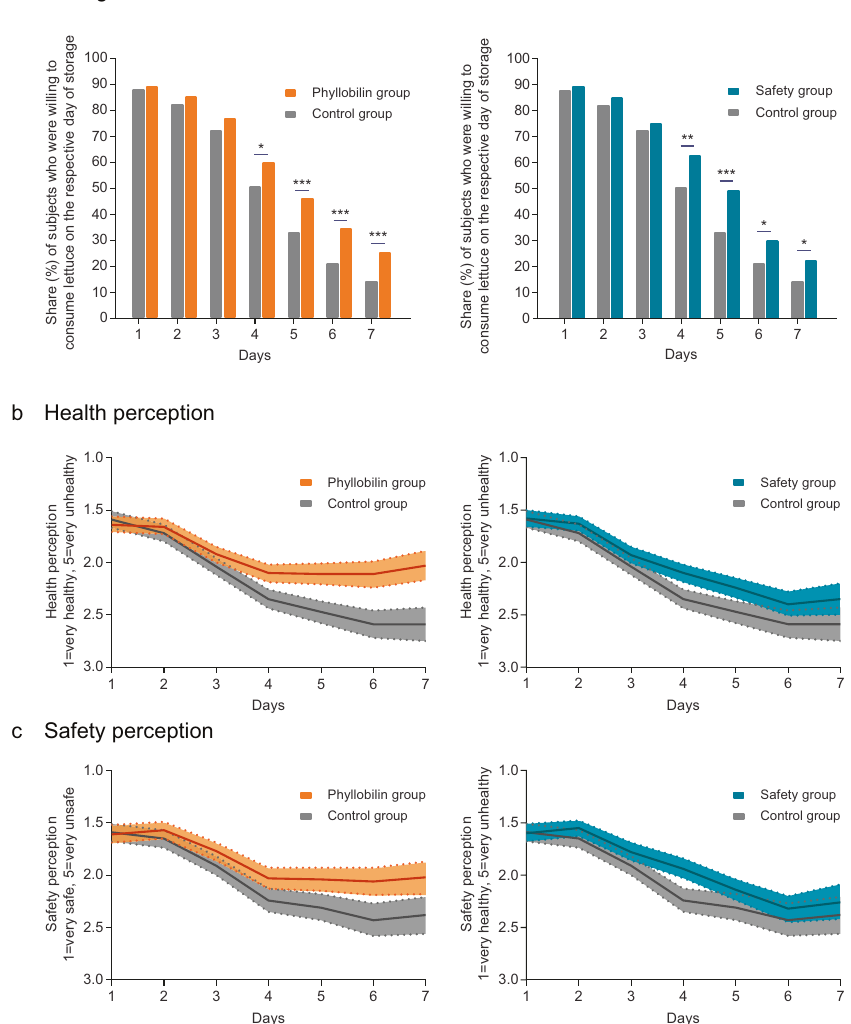
Fig. 2 Results of consumer online experiment ( N = 1103). a Share (%) of subjects in the phyllobilin and control condition (left panel) and safety and control condition (right panel) who stated to be willing to consume the lettuce on days 1 – 7 of storage (bars, * p < 0.05, ** p < 0.01, *** p < 0.001, statistical analysis see Supplementary Table 3). b Health and c safety perception of the lettuce on a 5-point Likert scale on days 1 – 7 (mean values and 95% CI, statistical evaluation see Supplementary Tables 4 and